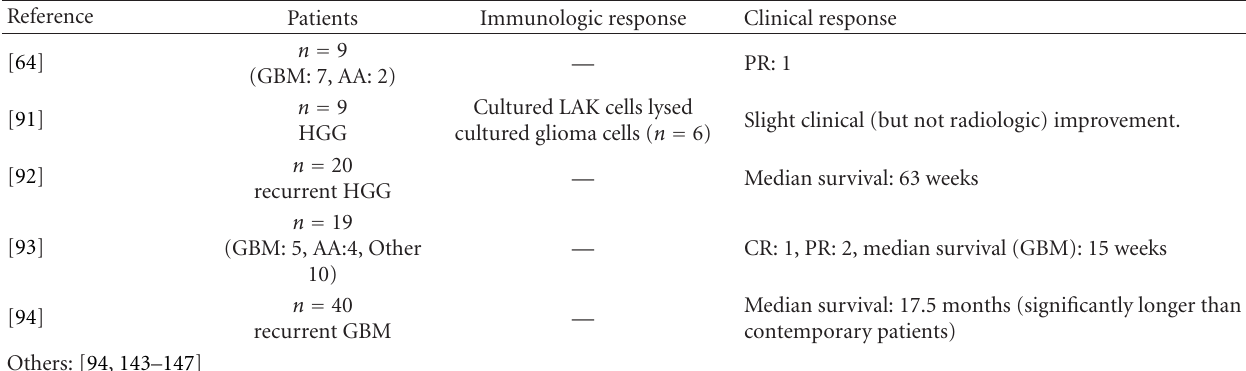
Table 2: Selected clinical trials using lymphokine activated killer (LAK) cells.